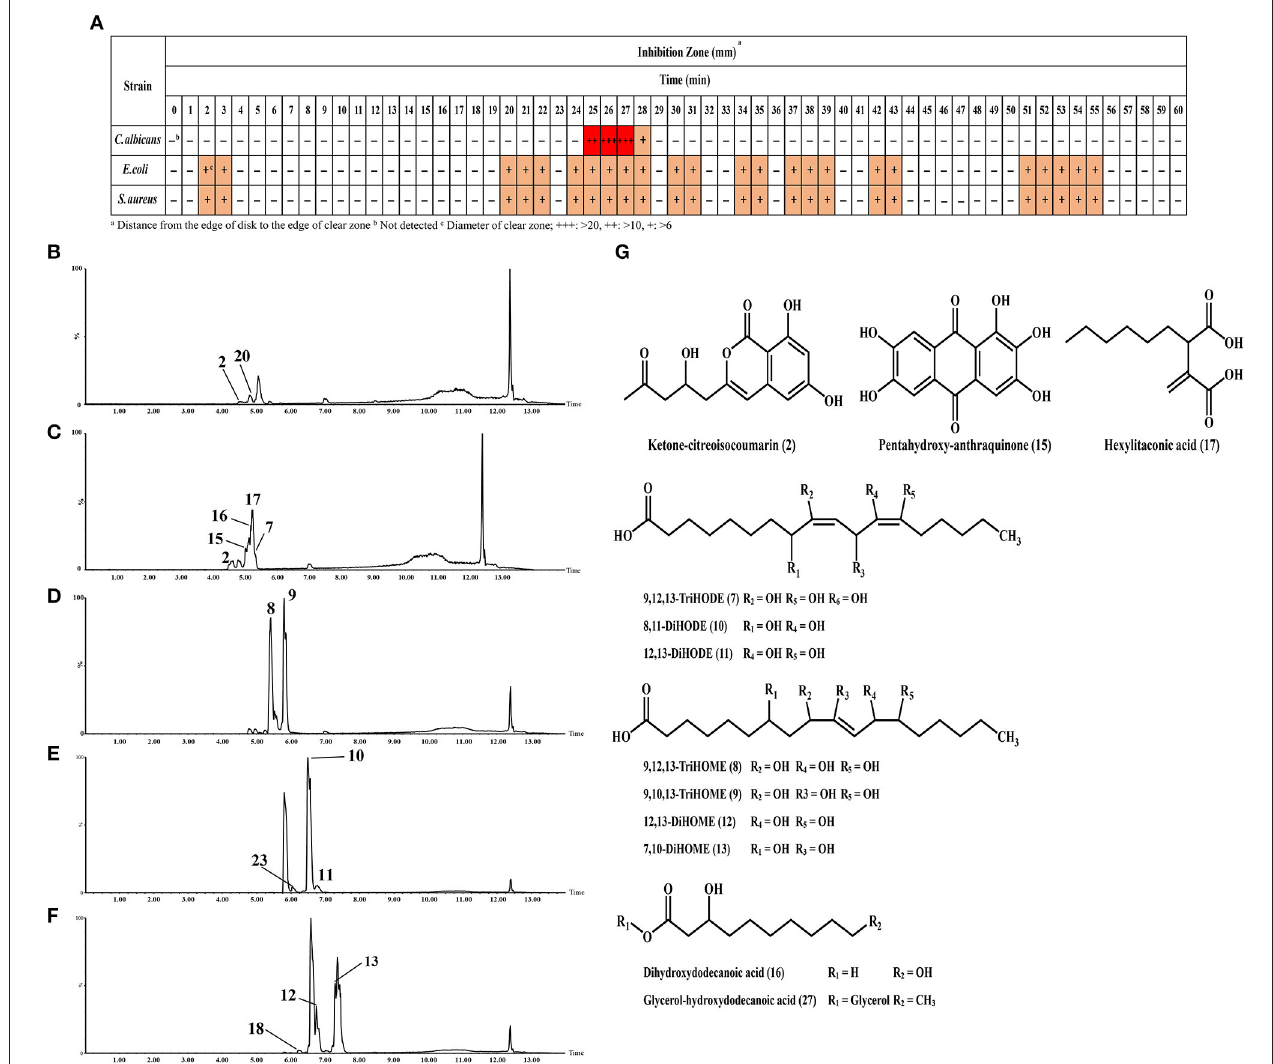
FIGURE 5 | (A) Antimicrobial activities (against C. albicans, E. coli , and S. aureus ) for preparative HPLC fractions from the 8 days incubated SSF A. oryzae extracts. Chromatograms for (B) 22min, (C) 25min, (D) 27min, (E) 31min, and (F) 38min indicate the bioactive metabolites of each prep fraction. (G) Structure of identified